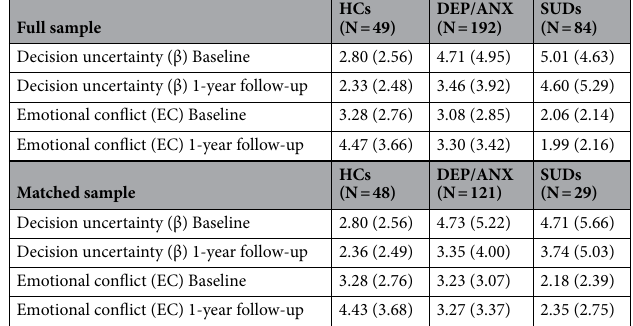
Table 3. Summary statistics (mean and SD) and group differences for computational